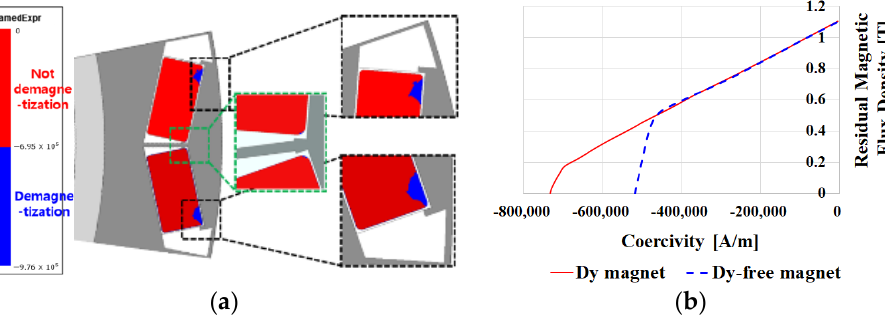
Figure 3. The irreversible demagnetization area of the conventional model and the B–H curve based on Dy-free magnet at 150 °C: ( a ) area of irreversible demagnetization; ( b ) B – H curve of Dy-free magnet (second quadrant).